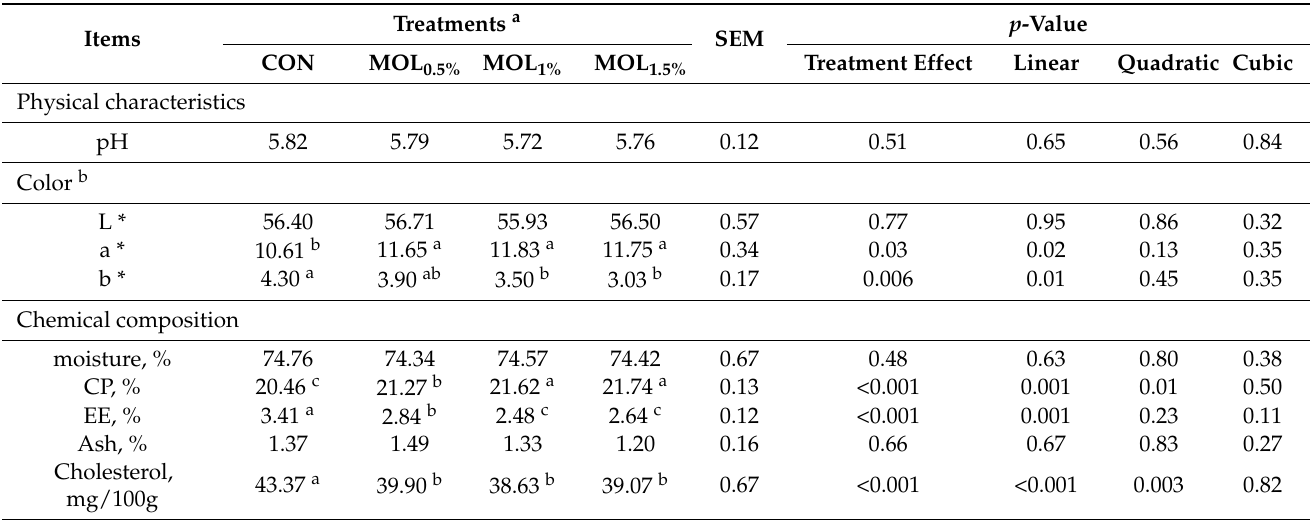
Table 5. Meat physical and chemical characteristics of growing rabbits fed the experimental